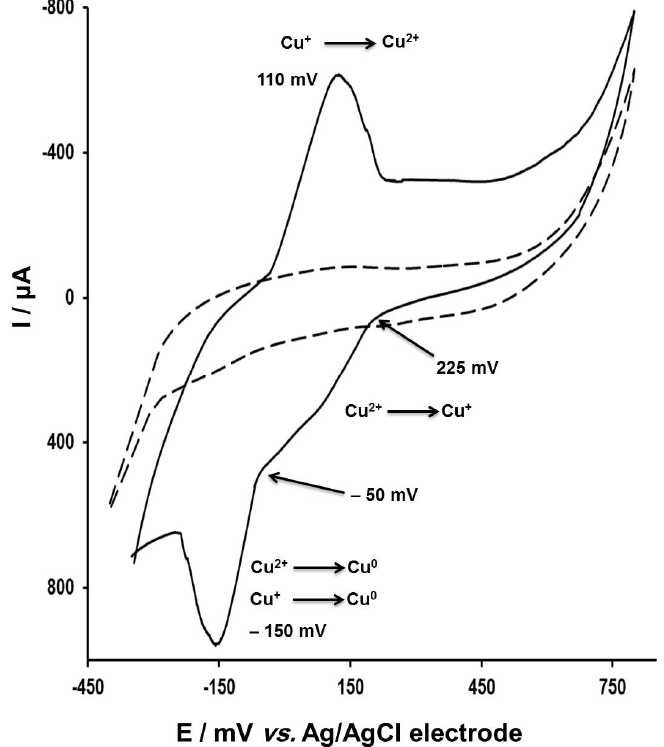
Figure 5. Typical cyclic voltammogram recorded in blank phosphate buffer (pH ≈ 8) using carbon paste electrodes (CPE) (dashed line) and Cu 2 ONPs-C@G/PE (solid line).